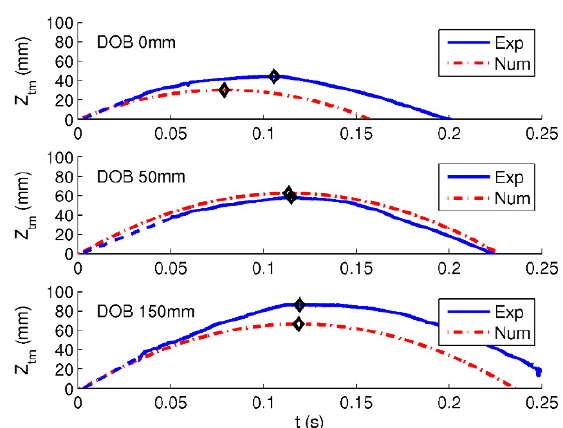
Figure 19. Numerical and experimental trends of burial depth (DOB). Diamonds corresponds to the max dynamic plate defor- mation on the left axis, circles corresponds to the trans- ferred impulse on the right axis. Symbols filled with black corresponds to experiment, white to numerical